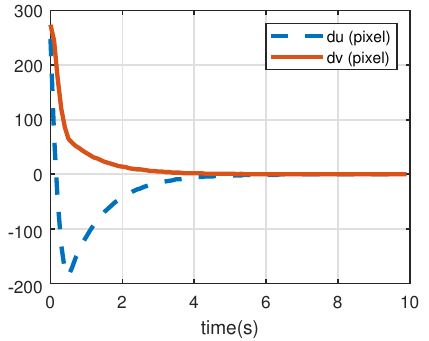
Figure 8. The evolution of image